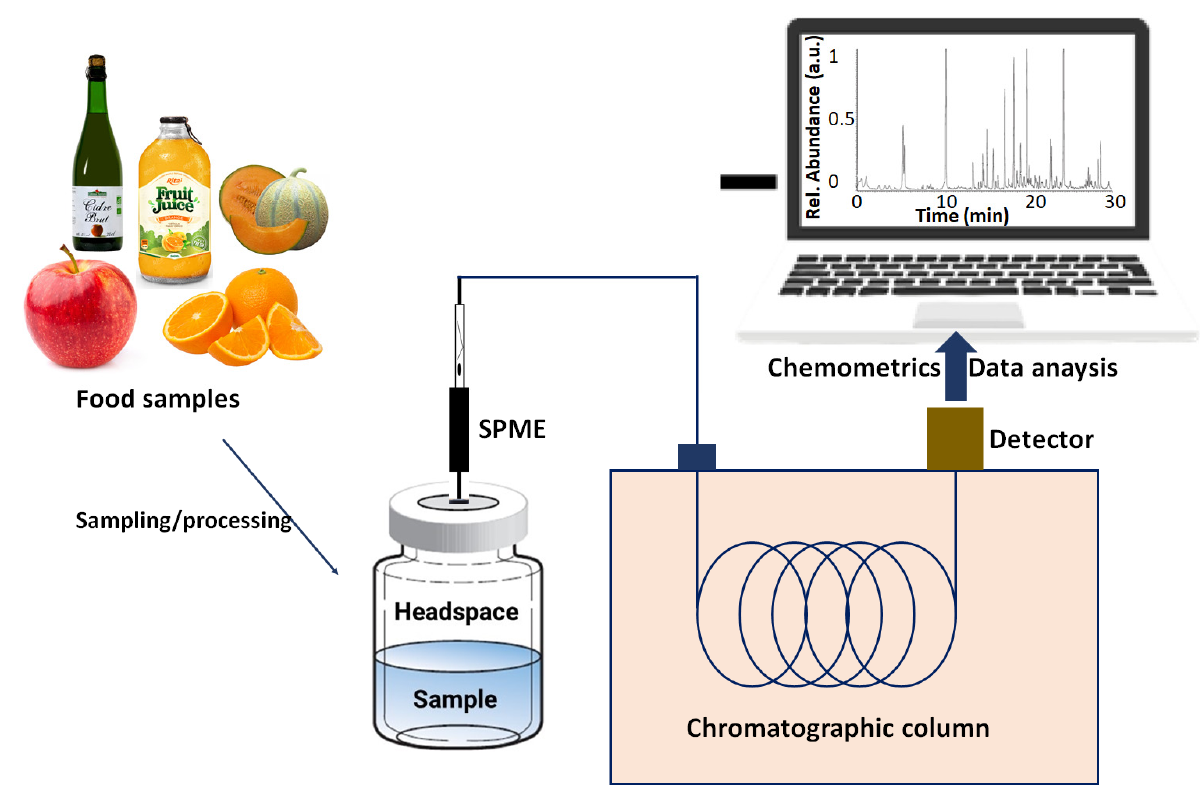
Figure 3. Schematic illustration of food sample analysis by gas chromatography coupled with a mass spectrometer detector and chemometrics data treatment.